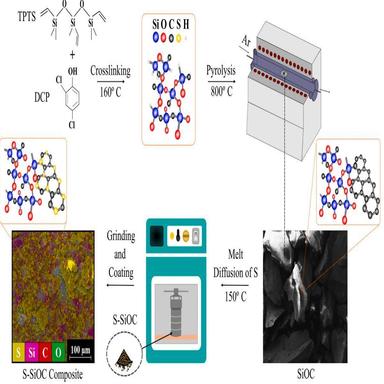
Fabrication route of the SiOC and S-SiOC powders, depicting the cross-linking, pyrolysis, melt diffusion, grinding, and coating processes.